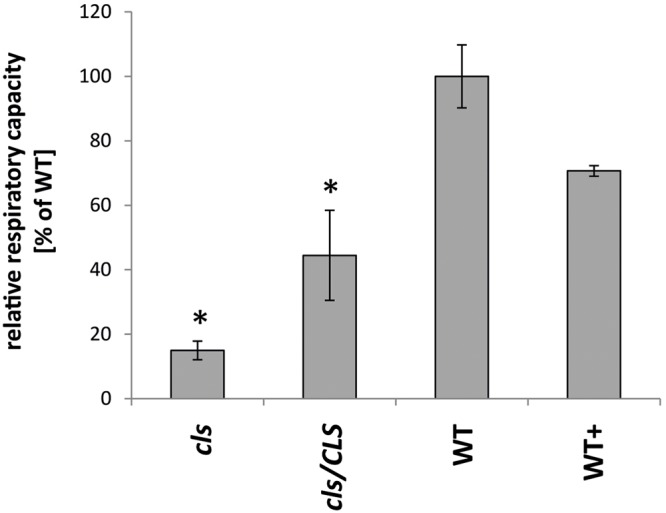
Respiratory capacities of cls, cls/CLS, WT, and WT+. Oxygen consumption rates of lysed mitochondria equaling 1mg of protein were monitored in a Clark-type oxygen electrode in the presence of 1mM NADH. Rates are expressed as arbitrary units of the mean WT rate (100%), error bars indicate standard error of mean of four biological replicates, asterisk indicates p < 0.05 when compared to WT.